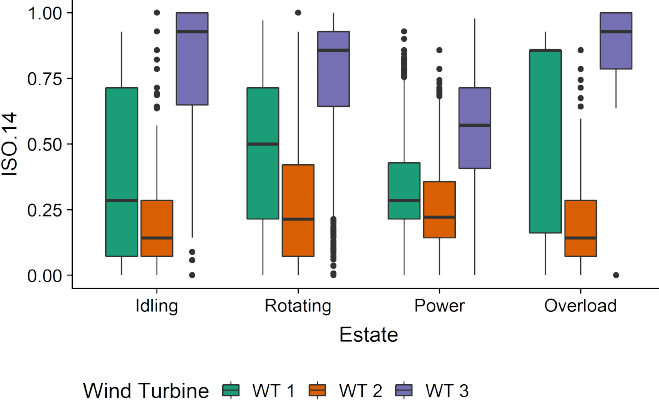
Figure 4. Boxplots of ISO.14 particle creation rates during different